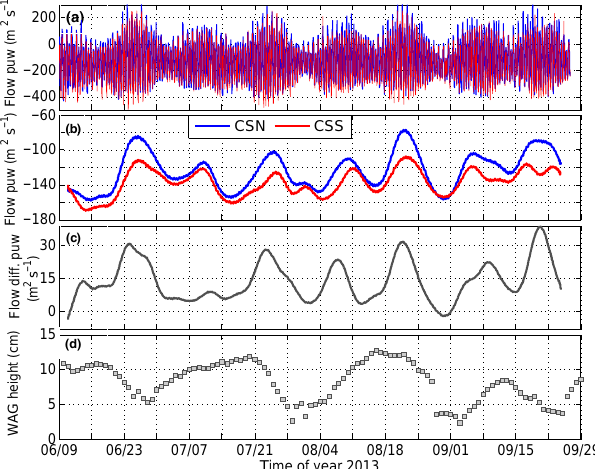
Figure 5. (a) Instantaneous flows per unit width across CSN and CSS (see legend). Negative sign indicates flow towards the Atlantic Ocean (outflow). (b) Low-passed flows per unit width. (c) Low- passed flow difference per unit width, computed as CSN–CSS from panel (b) . This difference is positive whenever the outflow through CSS is greater than through CSN, since both flows are neg- ative. (d) Daily mean sea surface height of the WAG (see text for